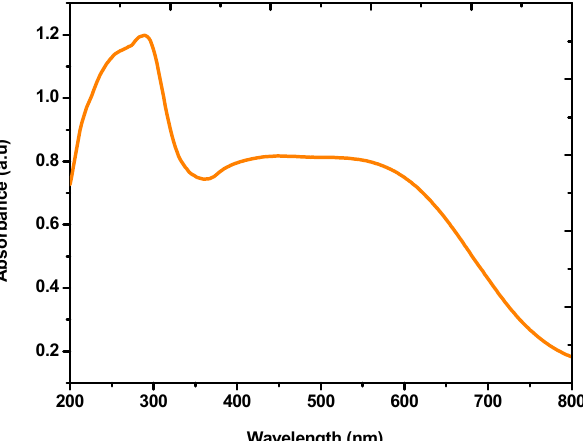
Fig. 4. EDX spectrum of the synthesized CeVO Fig. 4 EDX spectrum of the synthesized CeVO 4 NPs